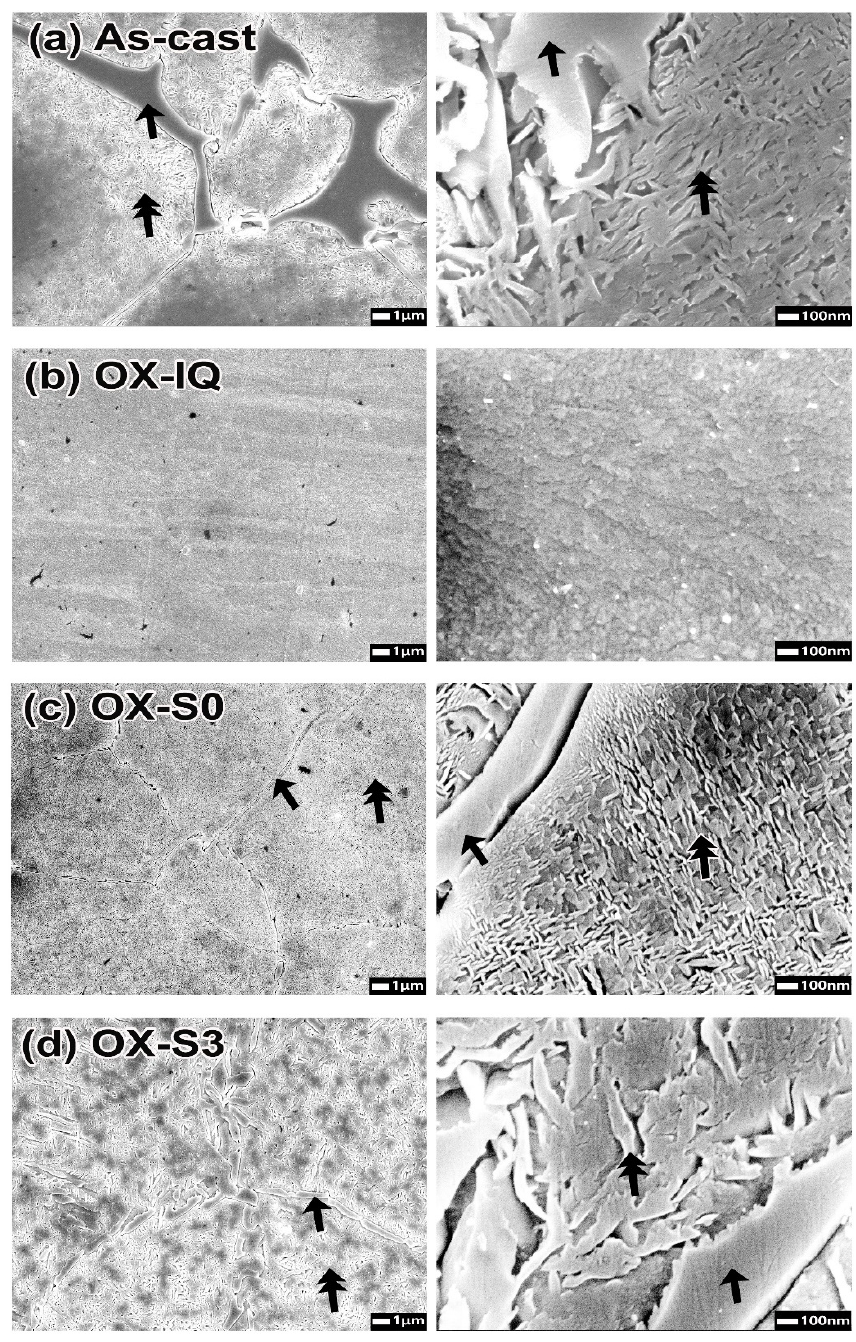
Figure 3. Microstructure after oxidation (left at 5000 × , right at 60,000 × ): ( a ) as cast; ( b ) OX-IQ; ( c ) OX-S0; ( d ) OX-S3. OX: oxidation. IQ: ice-quenching.